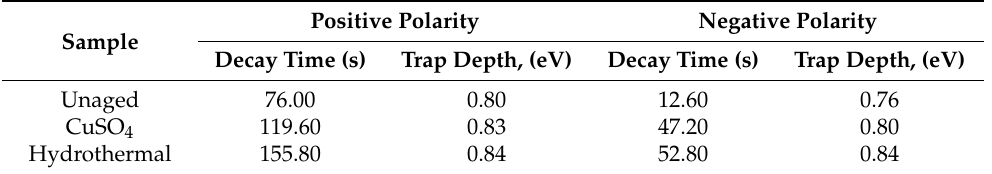
Table 2. Mean lifetime and trap parameters of XLPE under DC voltage.